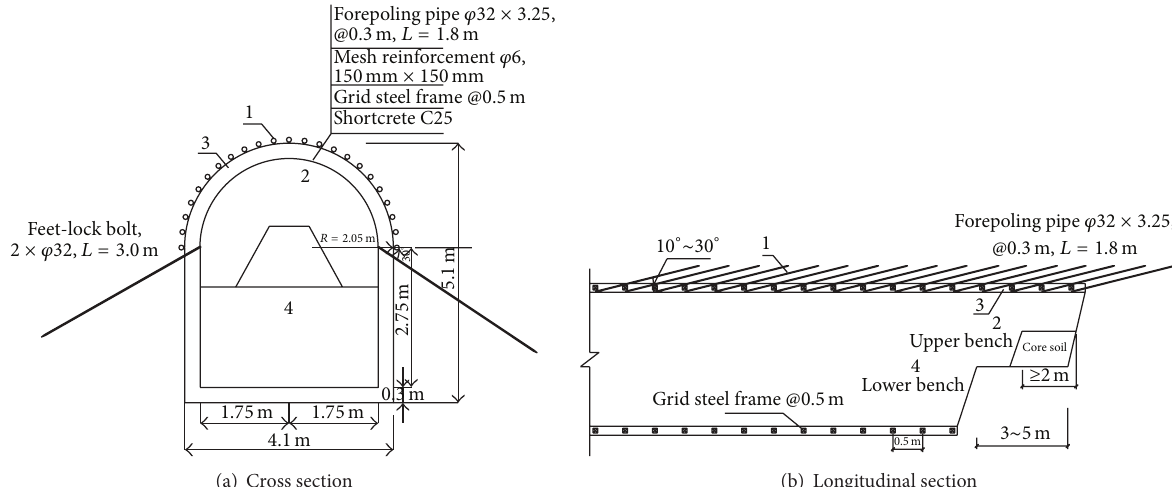
Figure 11: Excavation sequence of the pilot heading.